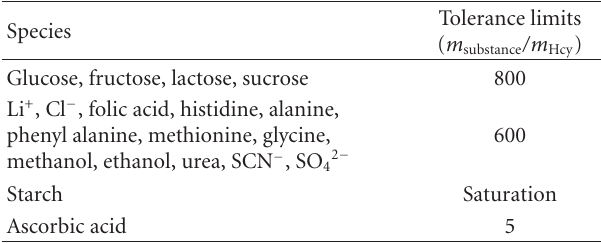
Table 3: Interference study for the determination of 5.0 μ molL − 1 Hcy under the optimized